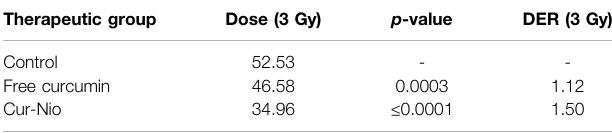
TABLE 2 | Comparison of dose enhancement ratios (DER) between the free curcumin and Cur-Nio at a single dose of 3 Gy after 48 h. Therapeutic group